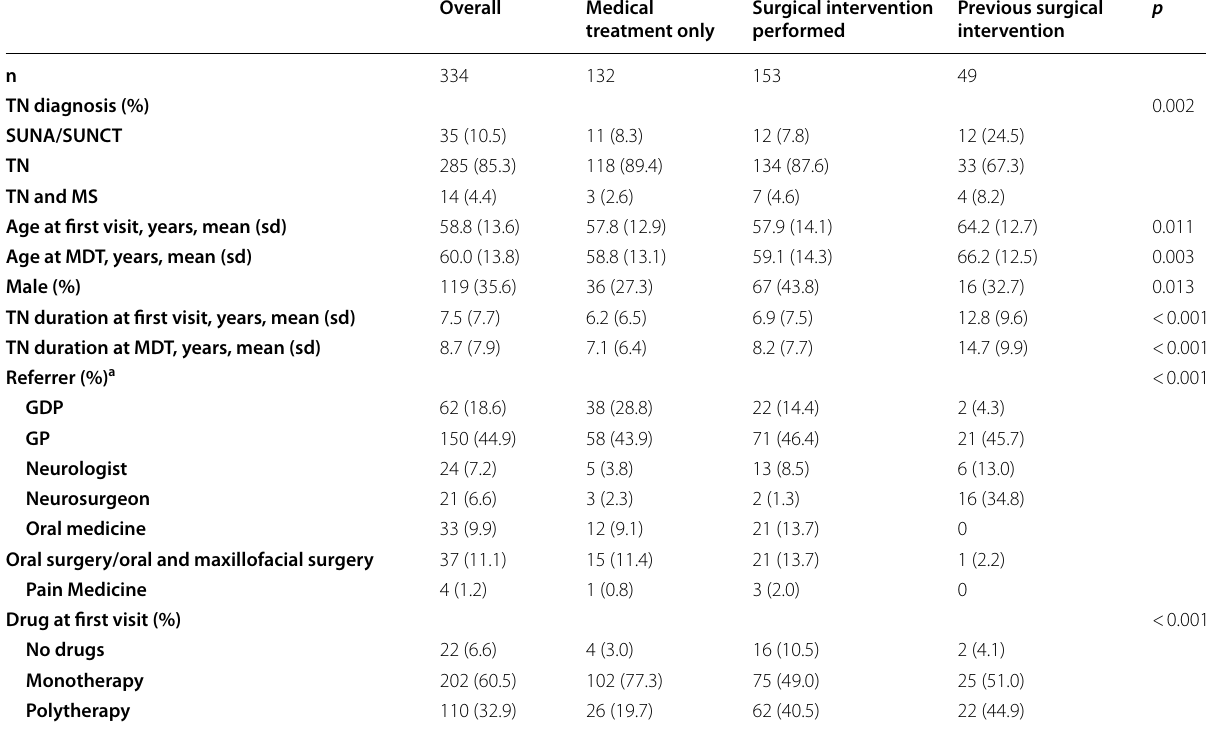
Table 1 Basic demographics and status at time of referral